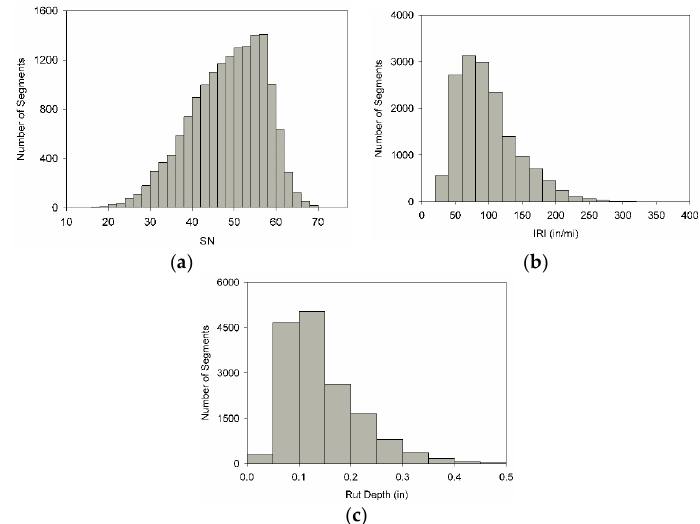
Figure 2. The histogram for the pavement condition including ( a ) SN; ( b ) IRI; and ( c ) RD; for the segments included in the study.